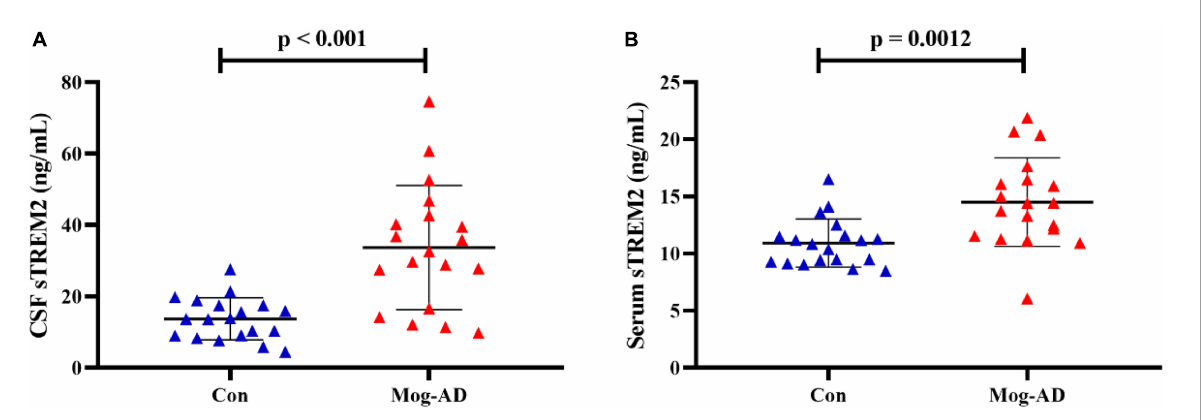
FIGURE1 High level of CSF and serum sTREM2 in MOG-AD pediatric patients. (A) sTREM2 levels in cerebrospinal fluid samples from the pediatric MOG-AD group ( N = 19) were significantly higher than the control groups ( N = 19) ( p < 0.001). (B) sTREM2 levels in serum samples from the pediatric MOD-AD group ( N = 19) were significantly higher, compared with the control group ( N = 19) ( p = 0.0012). Independent two-sample t -test were used for differential analysis.